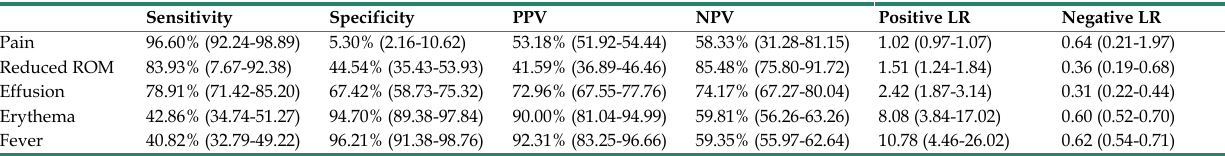
Table 2 . Diagnostic abilities of the various clinical presentations. Sensitivity Specificity PPV